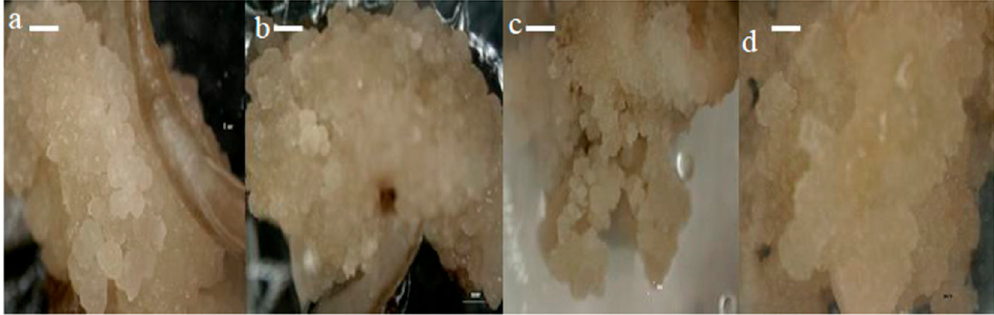
Figure 2. The callus morphology of MR220 ( a ), MR220-CL2 ( b ), MR232 ( c ), and Bario ( d ) varieties on MS media supplemented with 3 mg/L of 2,4-D (Bar = 1 mm).